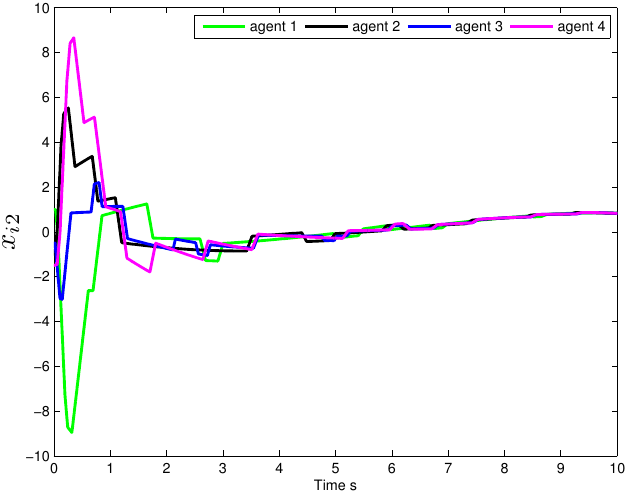
Figure 6. x i 2 ( t ) trajectories of MAS (42) with observer-based algorithm.